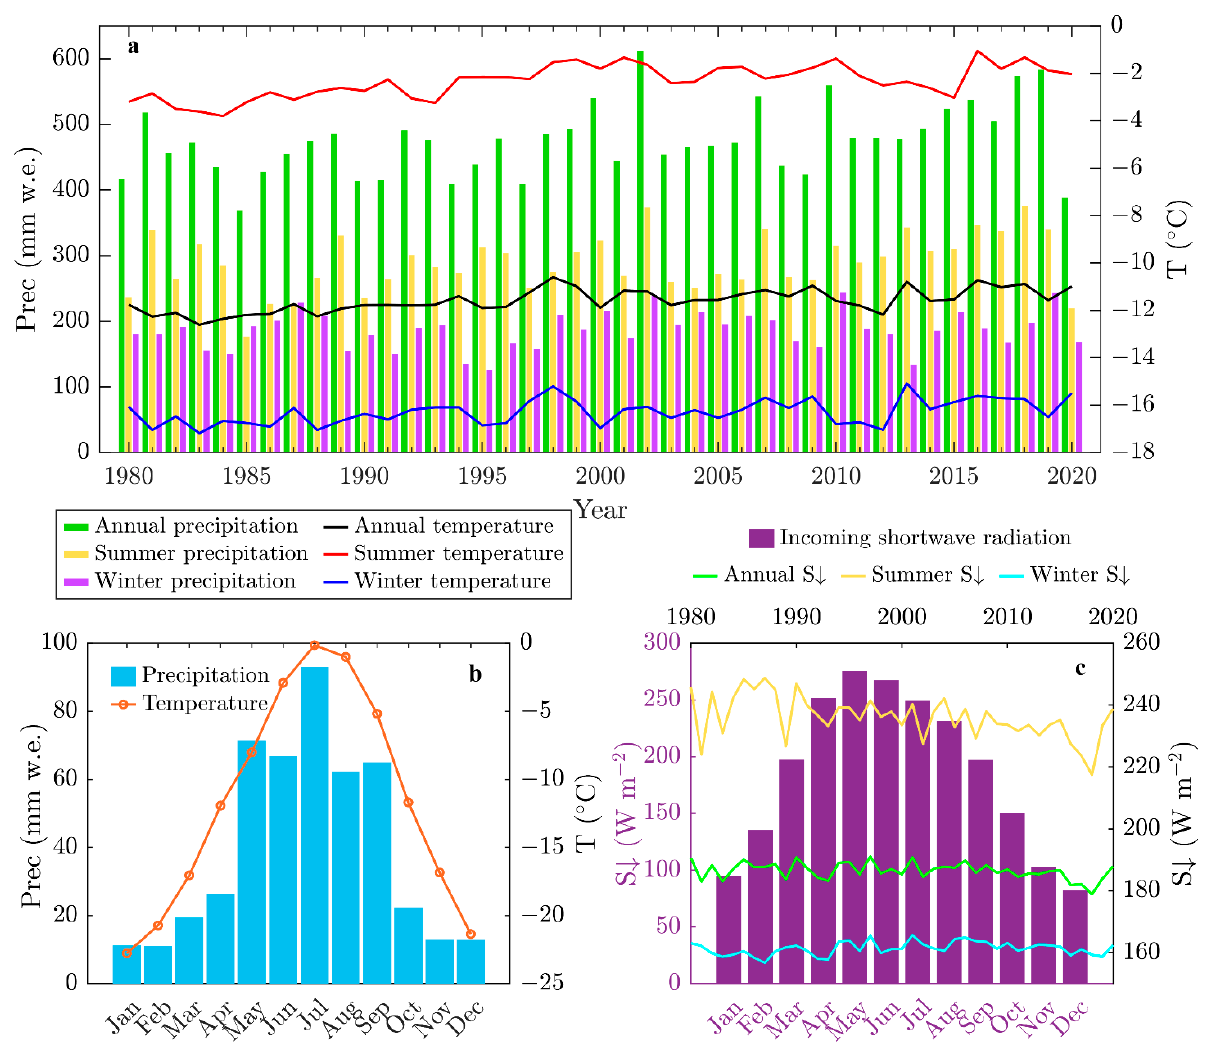
Figure 5. Meteorological elements of LHG12 from calibrated ERA5 during 1980 to 2020: ( a ) annual, winter and summer precipitation (Prec) and temperature (T), ( b ) monthly mean temperature and precipitation, and ( c ) annual, summer, winter and monthly mean incoming shortwave radiation (S ↓ ).